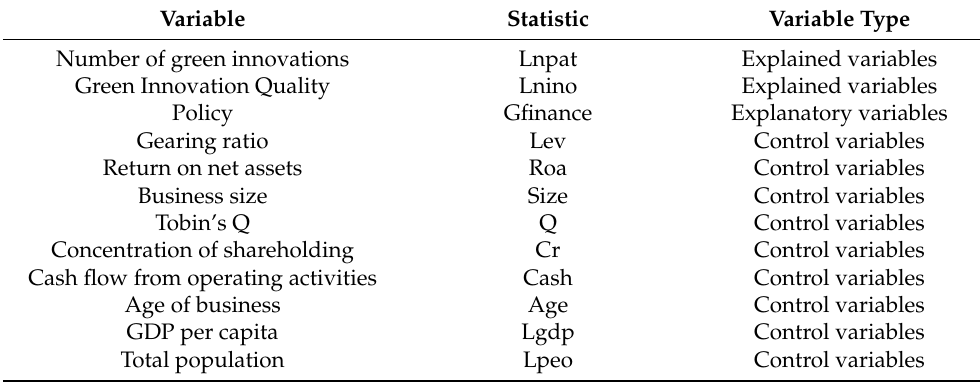
Table 1. Variable